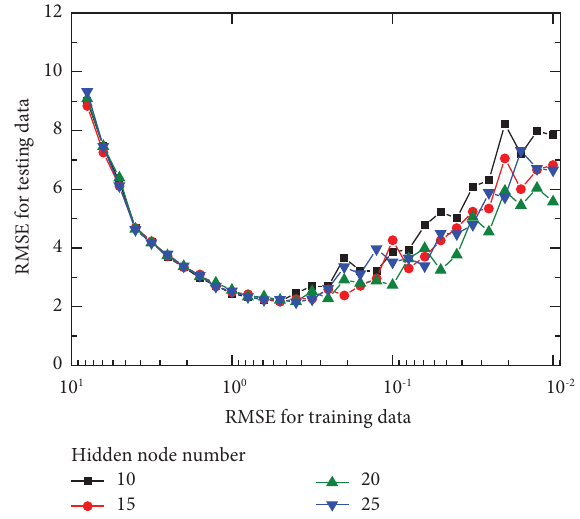
Figure 6: Average testing RMSE vs. training RMSE by Elman neural network